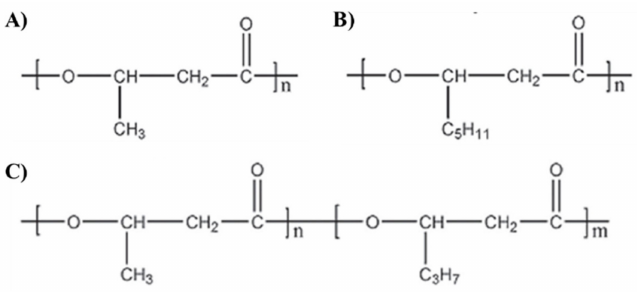
Figure 1. Chemical formulae of polyhydroxyalkanaotes (PHAs). ( A ) P(3HB); ( B ) P(3HO), ( C ) P(3HB-co-3HHx)